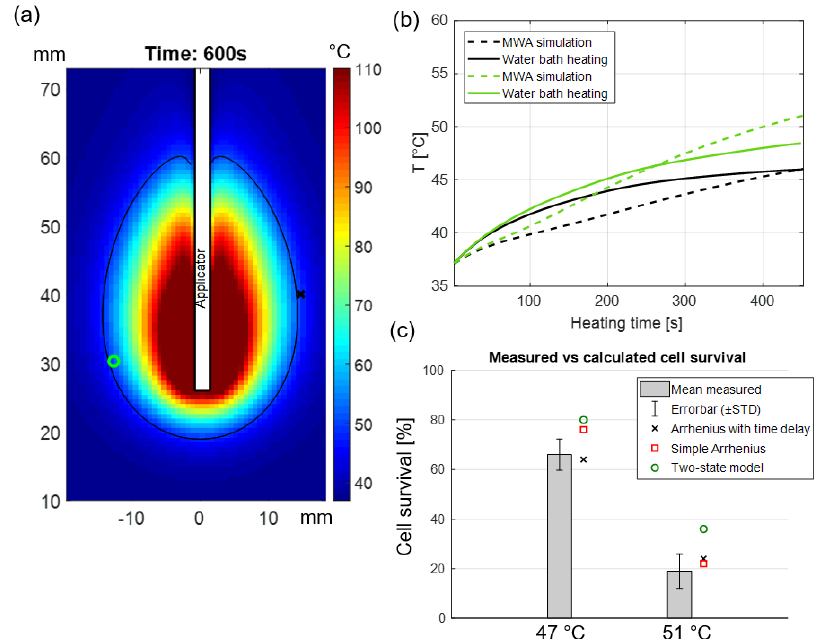
Figure 6. ( a ) Simulated temperature map in perfused pancreas tissue following 40 W, 10 min MWA, the black contour indicates the regions where 50 °C was achieved while the green circle and red x illustrate two positions along the periphery of the ablation zone where time-temperature history over 10 min was analyzed; ( b ) temperature profiles calculated from the bio-heat transfer model (shown in dashed lines) during 10 min MWA as well as experimentally measured temperatures in vitro during water bath hyperthermia (solid lines); ( c ) comparison between measured and calculated cell survival.